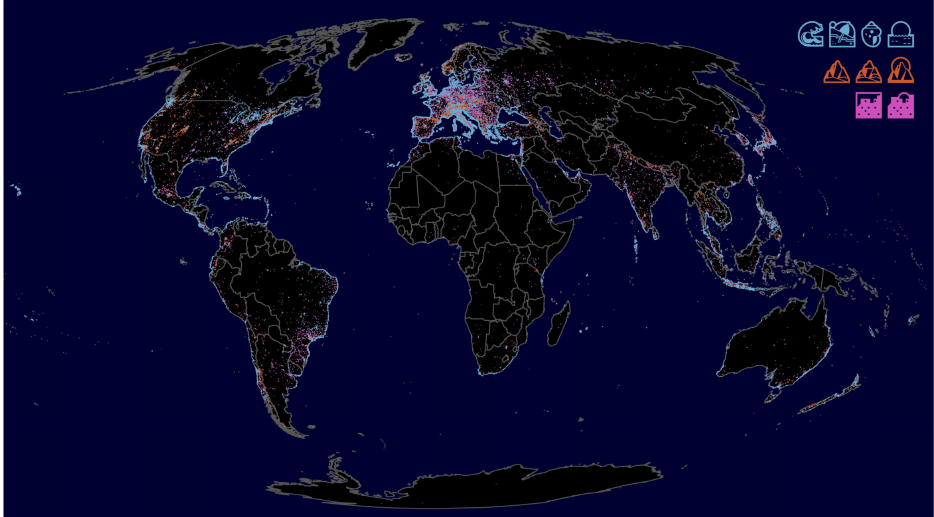
Figure 5. Global spatial distribution of location-specific emojis representing montane, urban and maritime